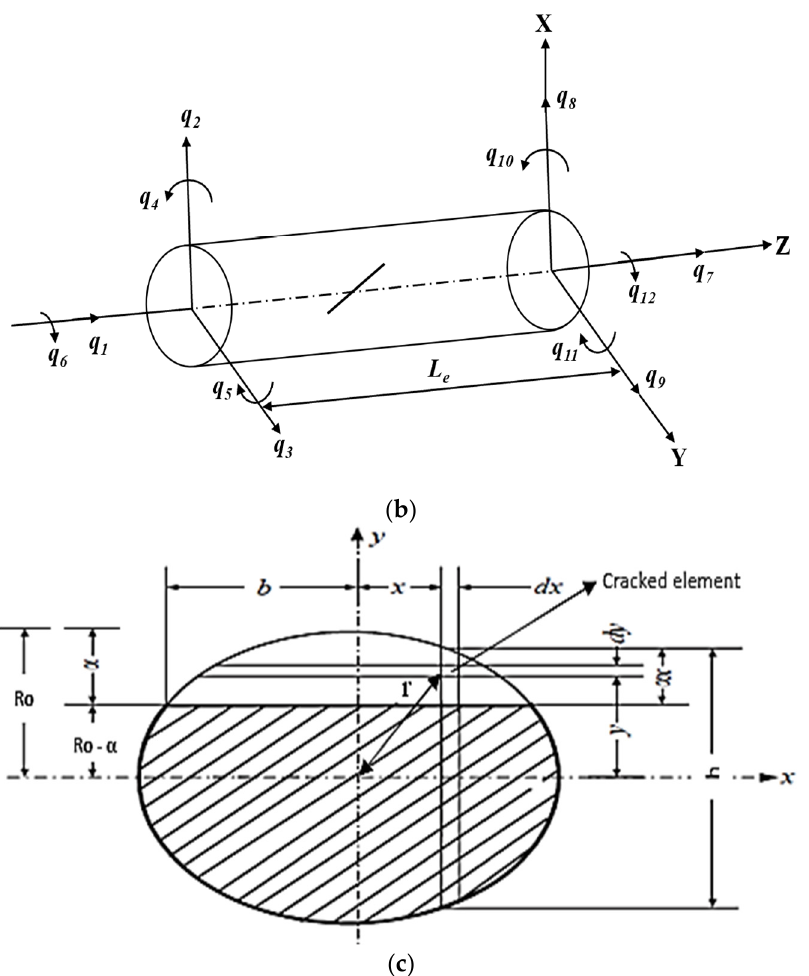
Figure 2. ( a ) A slant-cracked EG rotor-bearing system ( b ) An EG shaft element with a slant crack. ( c ) The cut sectional view of slant crack.